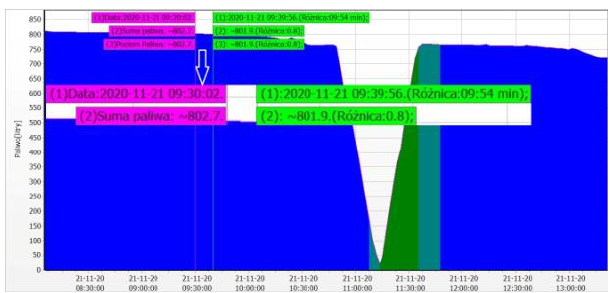
Fig. 7. Measurement of hourly fuel consumption FC [l/h] of a CAT C27 engine (6Dg locomotives) without additive. Test F, point